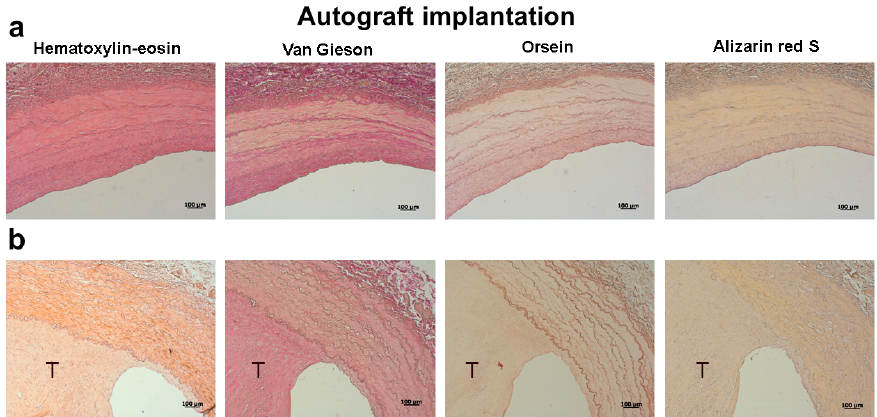
Figure 2. Histological examination of carotid artery autografts explanted 12 months following surgery. ( a ) Fully patent carotid artery. ( b ) Thrombotic carotid artery. The thrombus is indicated by the letter T. Scale bar = 100 µ m.